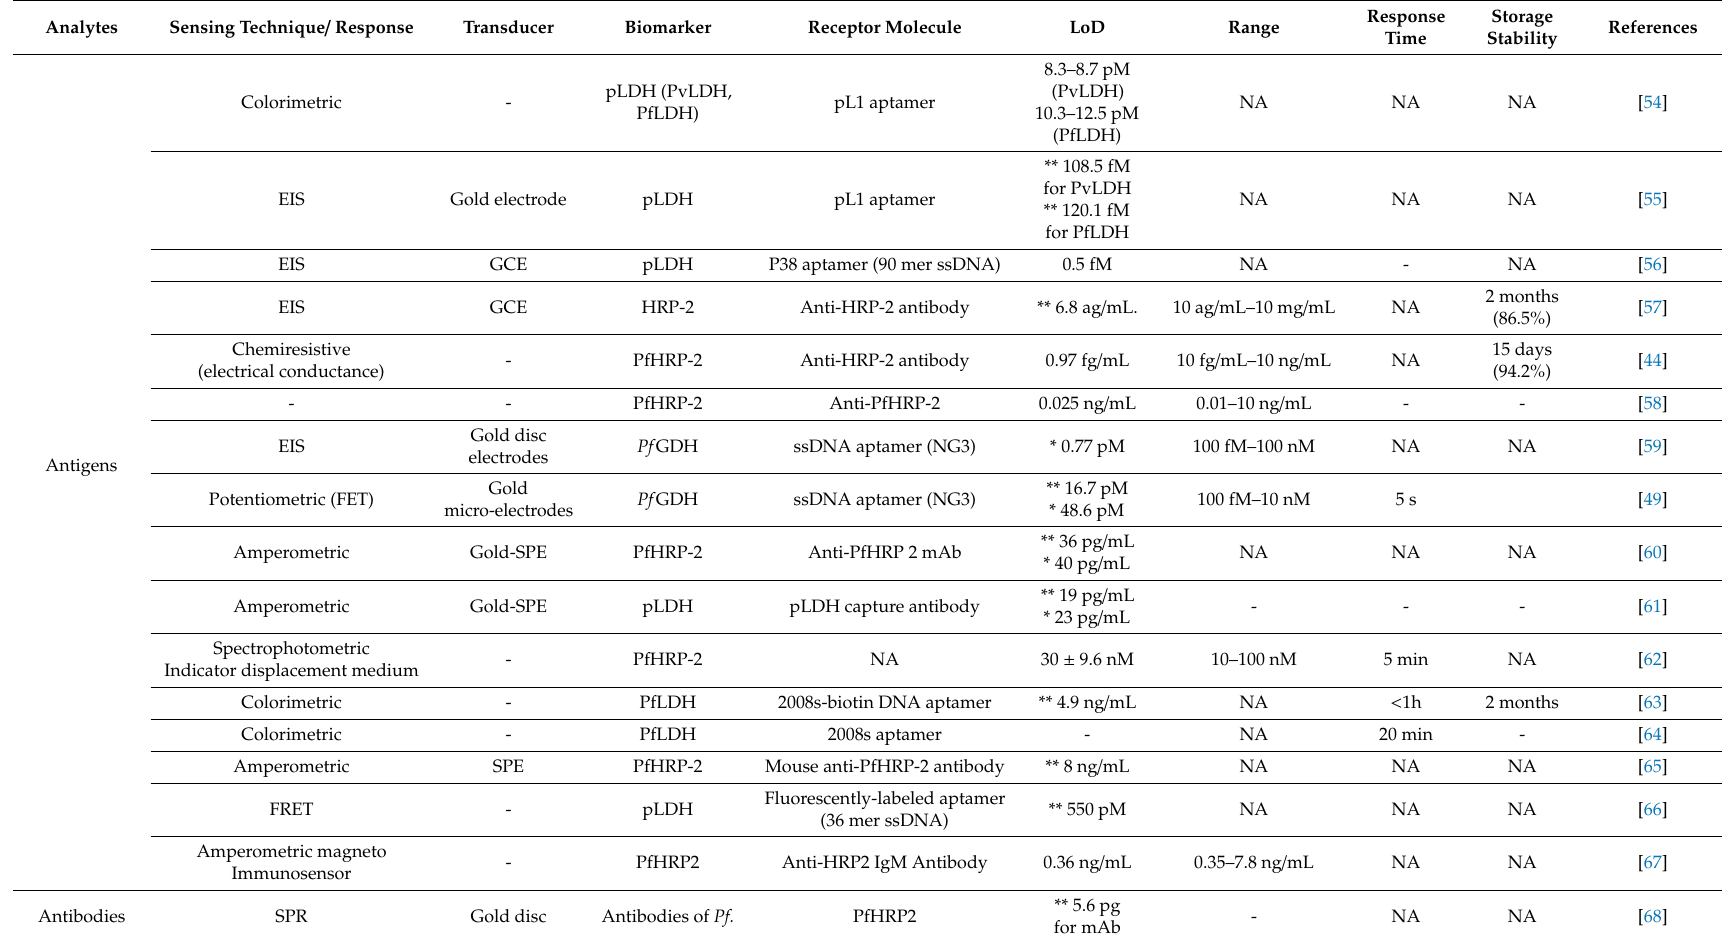
Table 1. Summary of selected biosensors reporting detection of various malaria